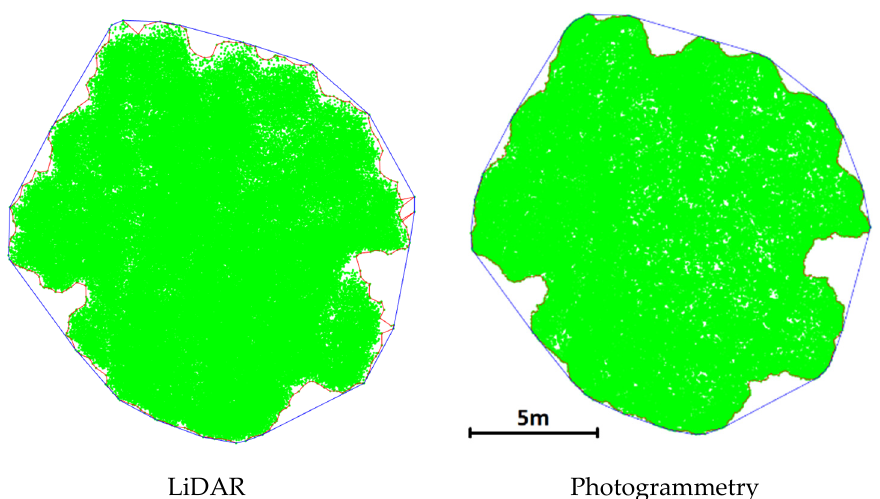
Figure 10. Comparison of different tree canopy maximum diameter area using LiDAR and photo- grammetric point clouds (convex hull in red and concave hull in blue).